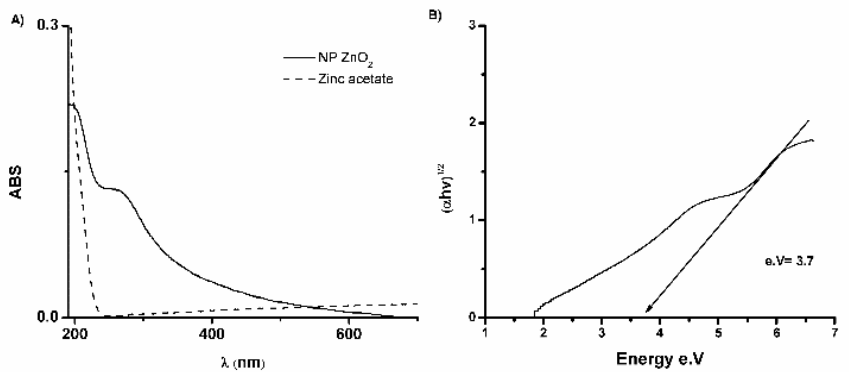
Figure 1. ( A ) UV-Vis spectrum of obtained ZnO 2 nanoparticles (black line) dispersed in water and comparison with reactant zinc acetate (dotted line) used for synthesis. ( B ) Indirect bandgap calculation for ZnO 2 nanoparticles.